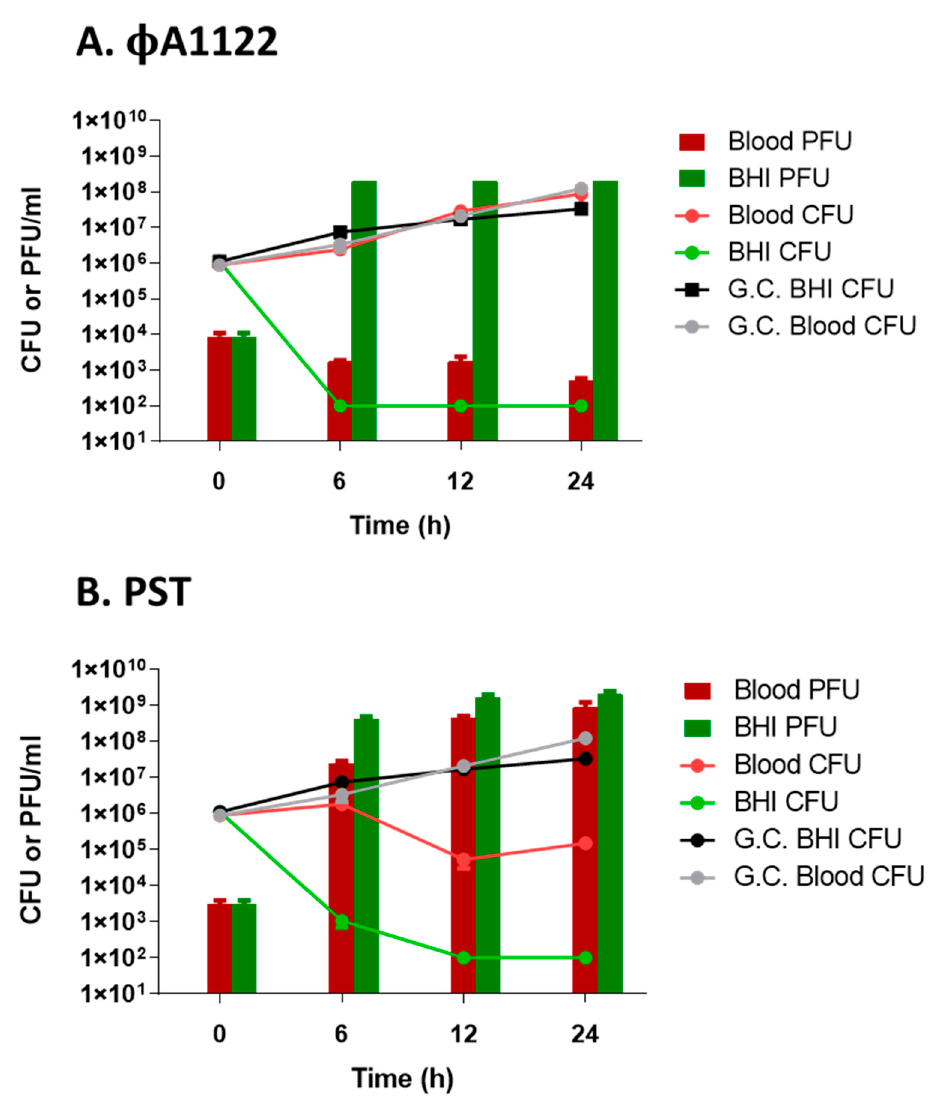
Figure 4. Phage and bacterial propagation assay. First, 37 ◦ C-prewarmed BHI or human blood (blood type O+, 6 days from uptake) was spiked with 10 6 CFU/mL Y. pestis strain EV76 and incubated at 37 ◦ C and 100 rpm for 1 h followed by φ A1122 ( A ) or PST phage ( B ) infection (MOI = 0.01). The infected cultures were incubated at 37 ◦ C and 150 rpm for 24 h. Samples (0.5 mL) were taken at the time of infection (T = 0) and 6, 12 and 24 h post infection. For bacterial enumeration, samples were serially diluted 10-fold in PBS, and 10 µ L of the diluted bacteria was spotted in triplicate on BHIA and incubated at 28 ◦ C for 48 h. For phage titration, samples were centrifuged at 1700 × g for 5 min at RT, and the supernatants were serially diluted 10-fold in SM buffer and used for phage titration by spot assay. Values are the average of triplicate spots in the same experiment, and the error bars represent the standard deviation (STDEV). G.C.= Growth Control